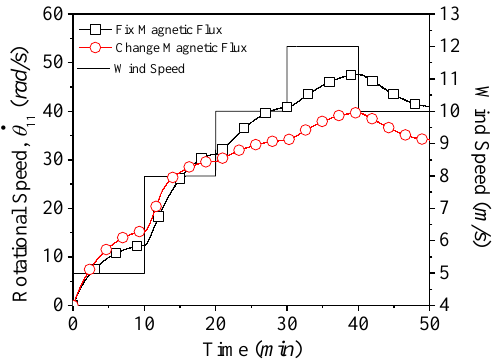
Figure 11. Rotational speed variation for the output shaft.